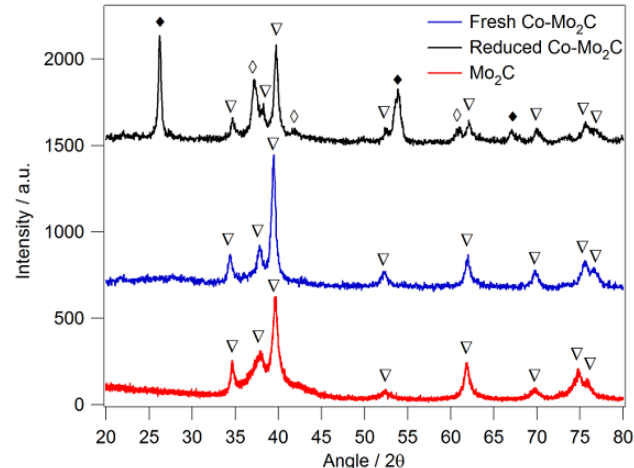
Figure 4. XRD pattern of fresh and reduced Co-Mo 2 C with Mo 2 C as a reference. The symbols correspond to the following: ▽ —β -Mo 2 C, ◊— CoMoC y O z , ♦ — MoO 2 , reproduced with permission correspond to the following: (cid:53) — β -Mo 2 C, ♦ —CoMoC y O z , (cid:7) —MoO 2 , reproduced with permission from [20]. Copyright Wiley-VCH, 2014. from [20]. Copyright Wiley-VCH,